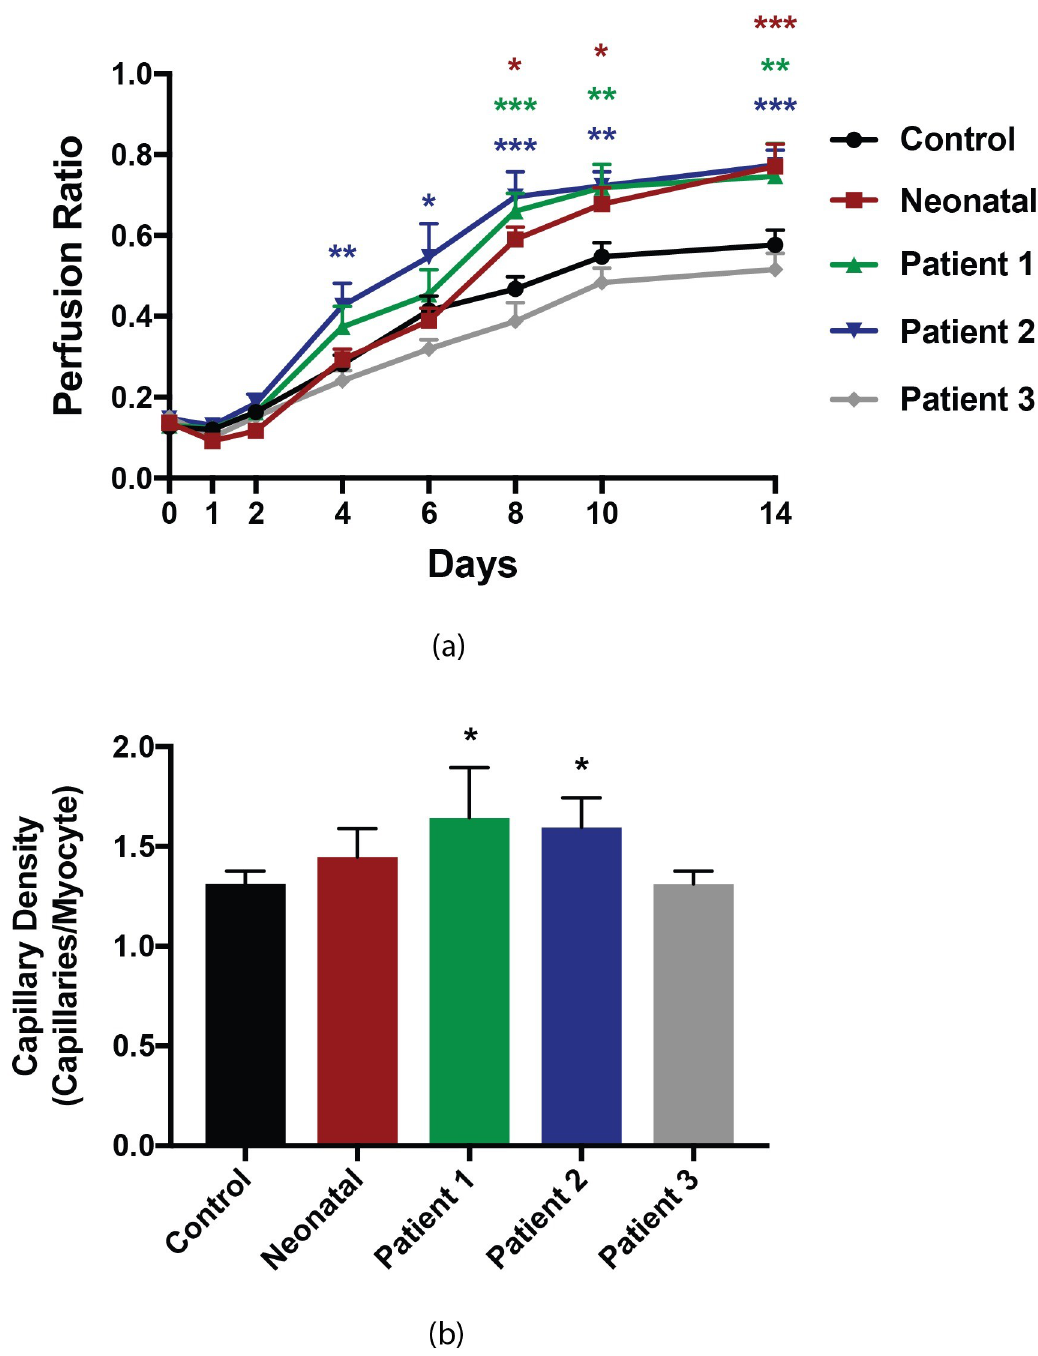
Fig 5. Blood perfusion recovery and capillary density in mice post hindlimb ischaemia surgery and treatment with iECs. (a) Blood perfusion recovery in ischaemic hindlimbs of mice treated with neonatal-derived iECs (red), patient-derived iECs from Patient 1 (green), Patient 2 (blue), and Patient 3 (grey), compared to controls (EBM) (black). Data were analysed by two-way repeated measures ANOVA and are presented as mean ± SEM (n = 23 for control group, n = 9 for iEC groups, � p < 0.05, �� p < 0.01, ��� p < 0.001 compared to control. Asterix colour denotes associated treatment group). (b) Capillary density (capillaries/ myocytes) for gastrocnemius muscle tissue from ischaemic hindlimbs collected at 14 days post-surgery for groups treated with neonatal-derived iECs (red), and patient-derived iECs for Patient 1 (green), Patient 2 (blue), and Patient 3 (grey), and control (EBM) (black). Data were analysed by one-way ANOVA with Bonferroni post hoc comparisons and are presented as mean ± SEM (n = 5–10 per group, � p < 0.05 compared to